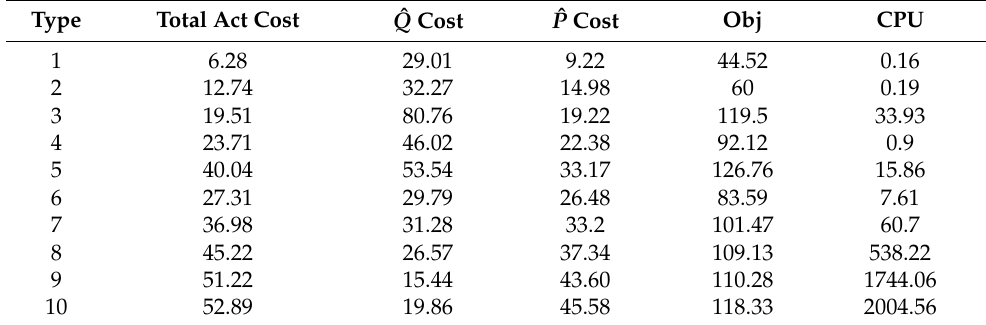
Table 2. First computational test. Results of cost component values.